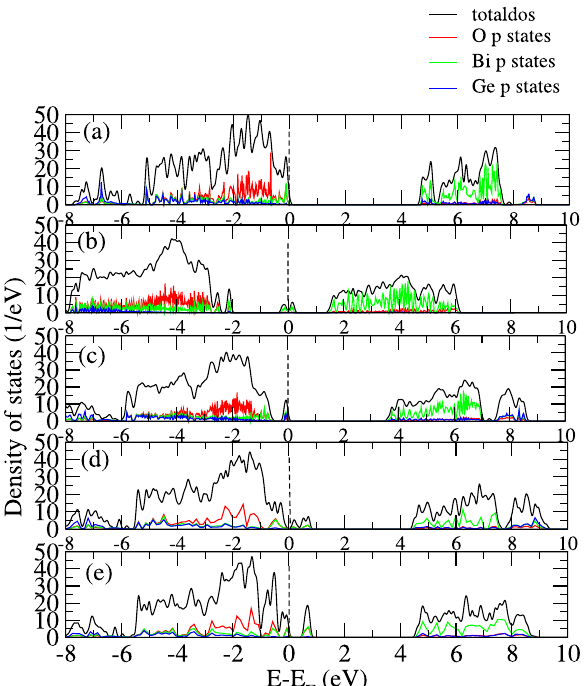
Figure 3. Total and partial density of states of ( a ) pristine BGO and BGO ( b ) antisite defect ( c ) O vacancy defect ( d ) Bi vacancy defect ( e ) Ge vacancy defect.